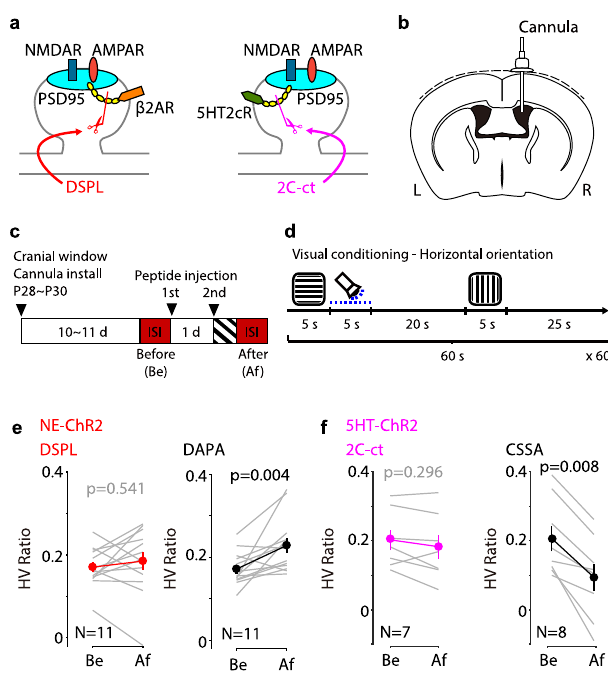
Fig. 2 Peptides targeting the conversion of eTraces prevent reinforcement-like conditioning of visual cortical responses. a Diagrams illustrating that DSPL (left) or 2C-ct (right) disrupts the direct interaction of the β 2AR or 5HT2cR with PSD-95, respectively. b A diagram illustrating the implantation of the cannula to inoculate the disrupting peptides to the lateral ventricle. c Experiment timeline. The peptide was injected 1 day (1st) and 30 min (2nd) earlier than the visual conditioning. d For the visual conditioning, horizontal or vertical drifting gratings were alternately shown at 30 s intervals. Photoactivation to induce the release of neuromodulators was retroactively coupled to the horizontal drifting gratings. e Summary of the HV ratio change by the visual conditioning in the presence of the disrupting peptide (DSPL) or the control peptide (DAPA) of the NE-ChR2 mice. f Summary of the HV ratio change by the visual conditioning in the presence (2C-ct) or the control peptide (CSSA) of the 5HT2cR disrupting peptide of the 5HT-ChR2 mice. Thin line: individual animals; thick line and symbols: average ± s.e.m. Source data are provided as a Source Data fi